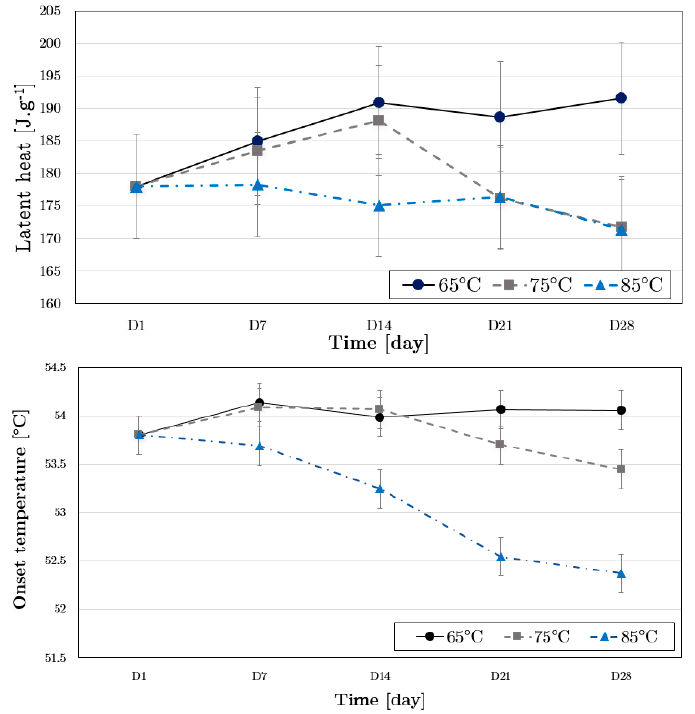
Figure 4. SA–PA mixture’s properties’ evolution over constant temperature exposure and in contact with polyolefin sample: latent heat of fusion (top) and onset temperature (bottom).